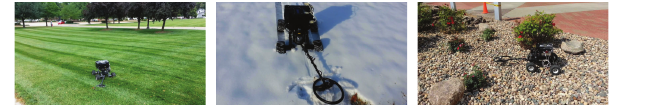
Figure 3: The Explorer robot searches for landmines in different types of environments. It is possible to scan areas covered by grass, snow, and rocks due to the characteristics of the